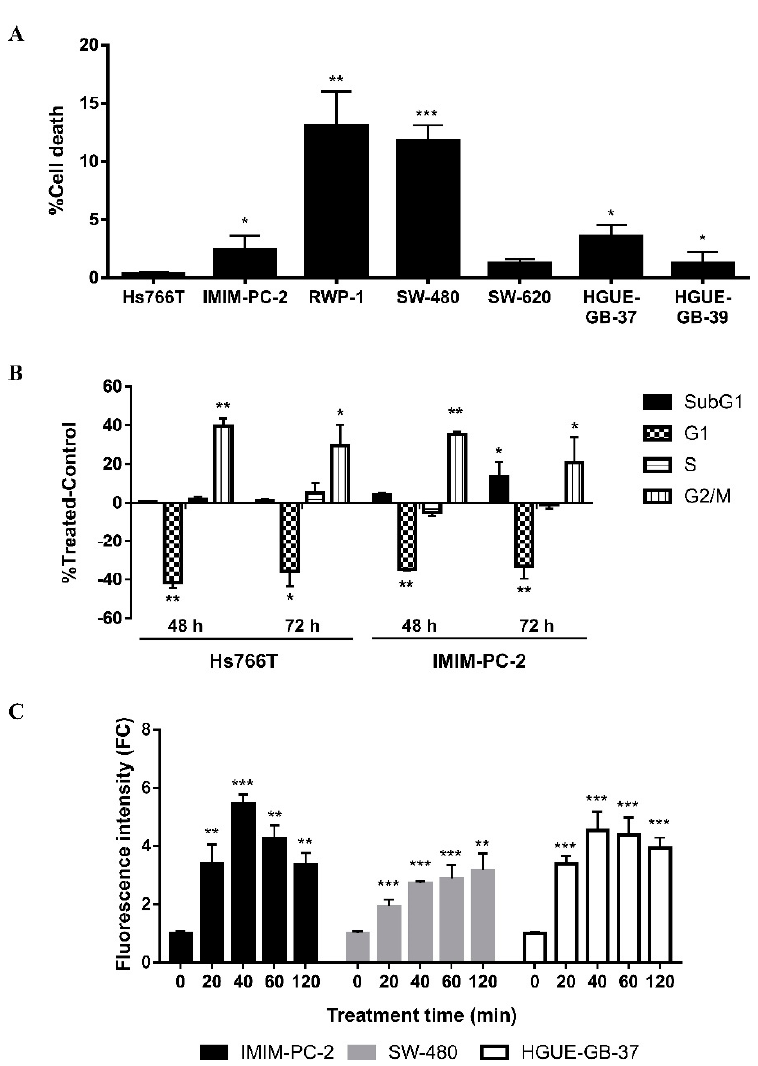
Figure 9. Differential effect of H 2 O 2 with respect to CLytA-DAAO and D-Ala treatment. ( A ) Plasmatic membrane rupture induced by H 2 O 2 in Hs766T, IMIM-PC-2, and RWP-1 cell lines from pancreatic carcinoma, SW-480 and SW-620 cell lines from colorectal carcinoma and HGUE-GB-37 and HGUE-GB-39 cell lines from glioblastoma. Cells were treated with 600 μ M H 2 O 2 for 24 h and cell viability was determined using Muse cell analyzer. Graph represents cell death percentage (mean ± SD) after subtracting cell death in the control untreated ( n ≥ 3). ( B ) Variations in cell cycle distribution after H 2 O 2 treatment for 48 and 72 h. Hs766T and IMIM-PC-2 pancreatic carcinoma cell lines were treated with 600 μ M H 2 O 2 for 48 and 72 h and cell cycle distribution was determined by flow cytometry. Graph shows the cells percentage ± SD in each phase of cell cycle after subtracting the cells percentage in the control untreated ( n ≥ 3). ( C ) Intracellular ROS increase after H 2 O 2 treatment in IMIM-PC-2 pancreatic carcinoma cell line, SW-480 colorectal carcinoma cell line and HGUE-GB-37 glioblastoma cell line. Cells were treated with 600 μ M H 2 O 2 for 20–120 min. Free radical production was determined through DCFH 2 -DA probe and each treatment time had a control untreated that only contained the probe. Graph shows the fold change (FC) ± SD of fluorescent intensity with respect to the control ( n ≥ 6). * indicates a p -value < 0.05, ** p -value < 0.01 and *** p -value < 0.001.